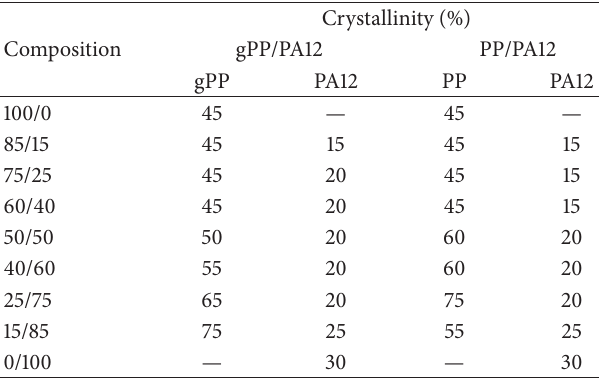
Table 3: Crystallinity of the components in the gPP/PA12 and PP/PA12 blends. The average standard deviation is